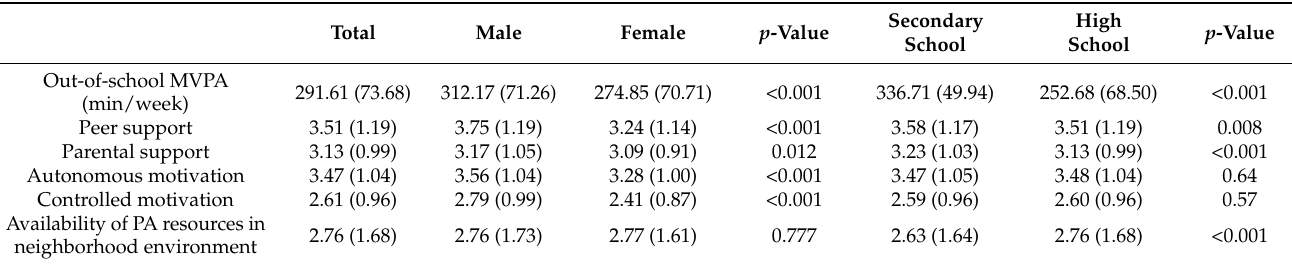
Table 2. Out-of-school MVPA, psychosocial variables, and neighborhood environment (mean and SD) by gender and educational levels.